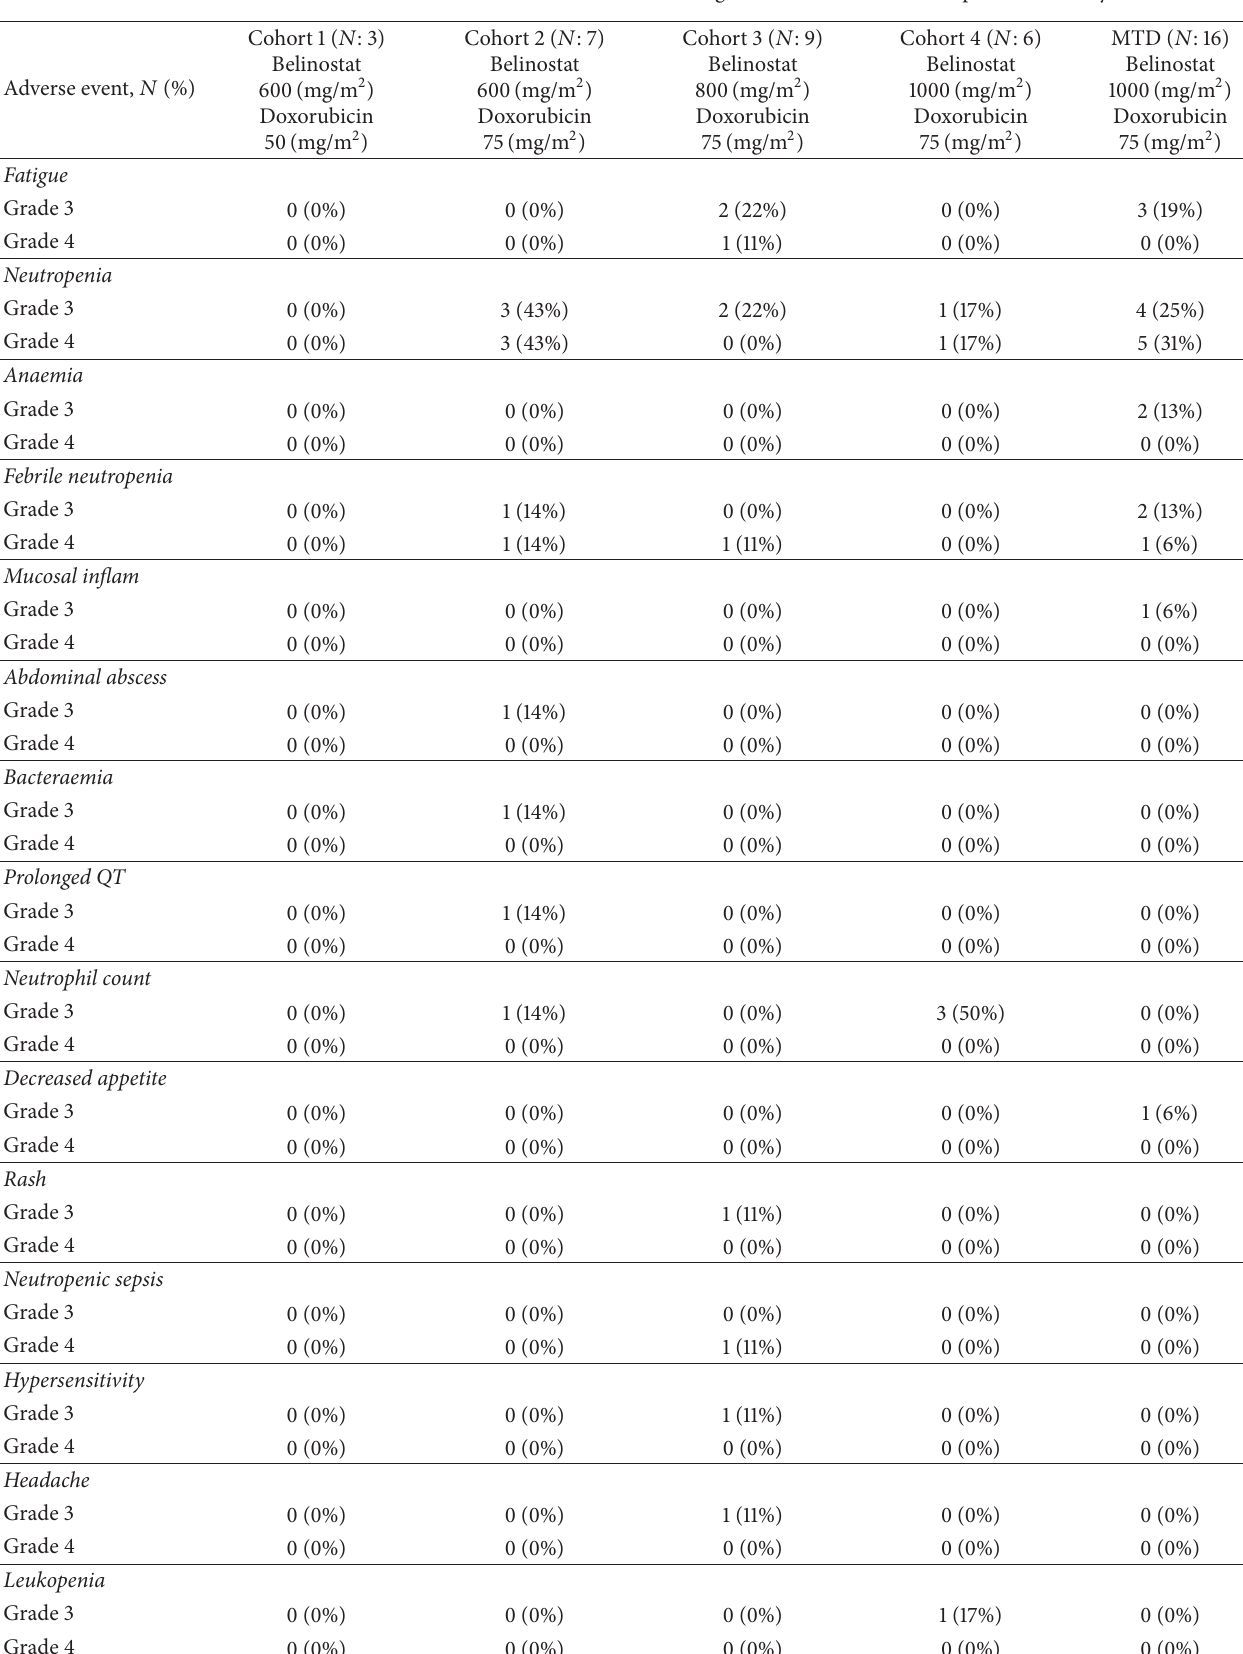
Table 3: Grade 3 and 4 treatment-related adverse events occurring in both the DE and MTD part of the study.